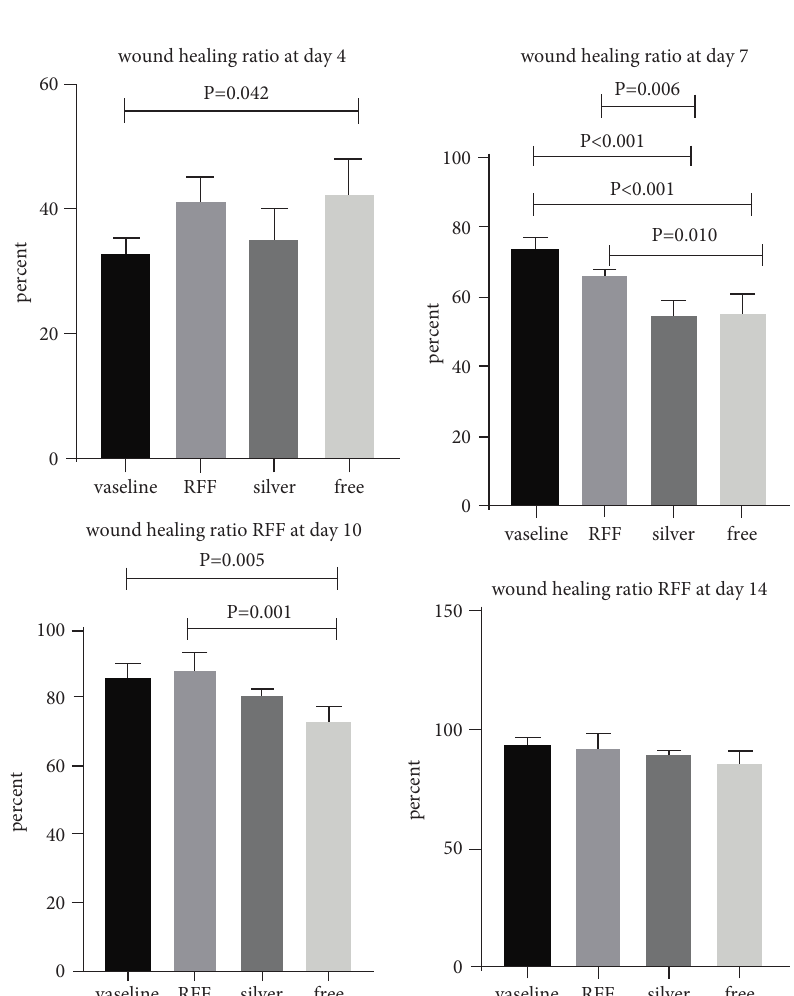
Figure 7: Wound healing ratio in silver, free, Vaseline, and RFF groups during the study on days 4, 7, 10, and